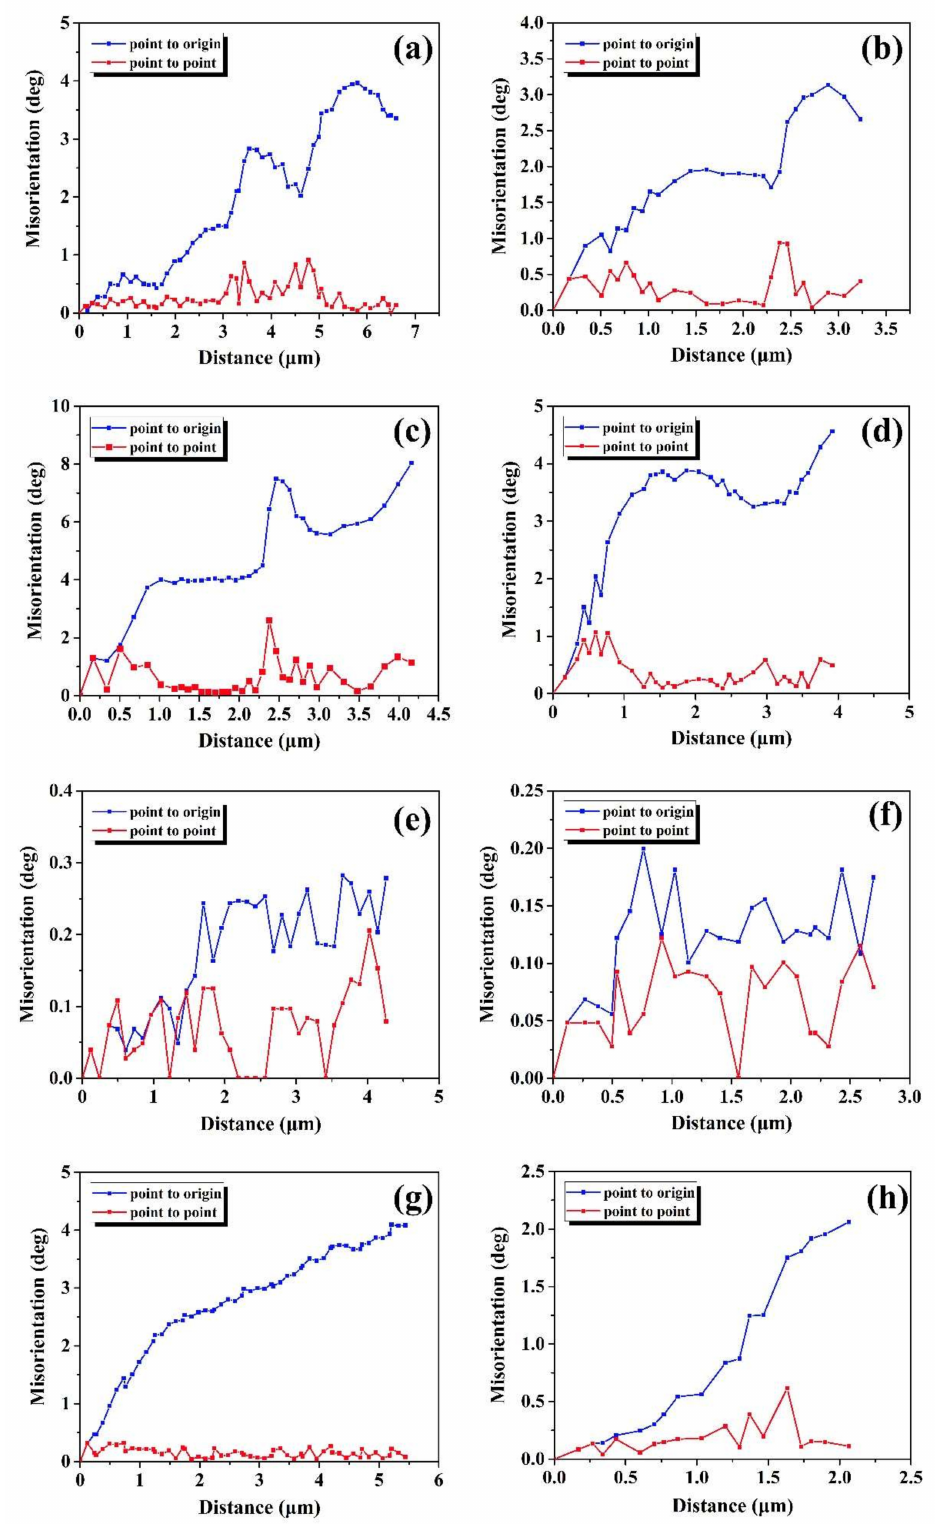
Figure 5. Evolution of misorientation corresponding to the lines indicated in Figure 4, severally: ( a ) A1; ( b ) A2; ( c ) C1; ( d ) C2; ( e ) E1; ( f ) E2; ( g ) G1; ( h )